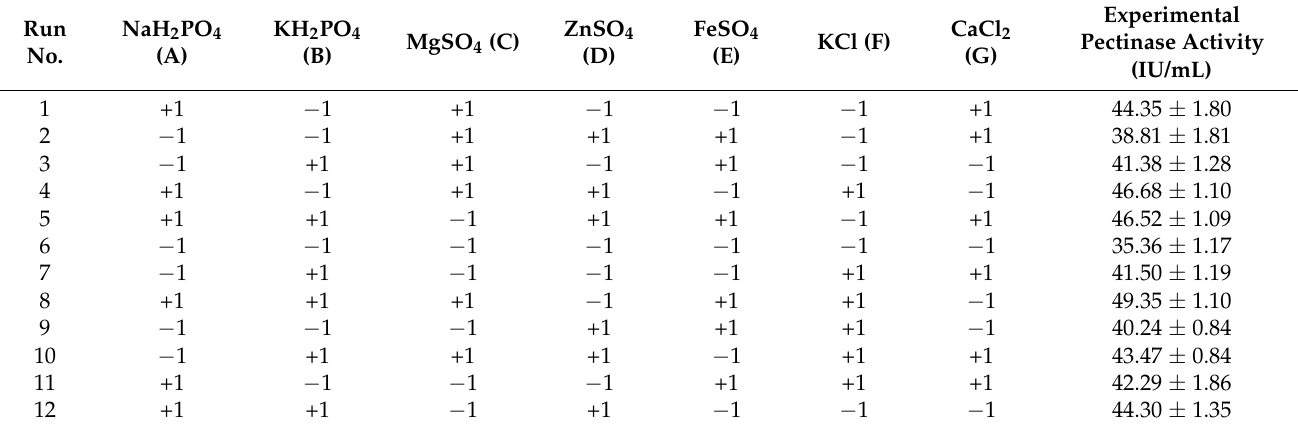
Table 9. The PB design matrix for mineral salts with the response.